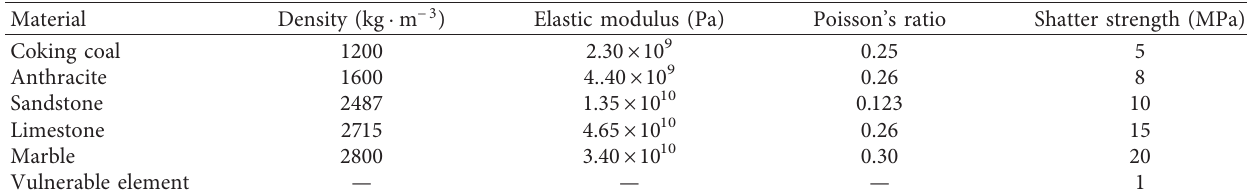
Table 4: Material properties of brittle coal gangue particles used in the simulation.